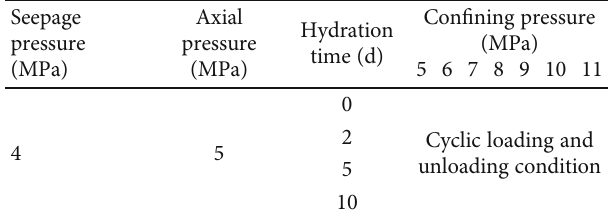
Figure 2: The shale samples with di ff erent hydrating days. The labels in Fig.2 are as follows, (a)No hydration (b) 2days (c)5 days (d) 10days. Table 1: The seepage tests of the hydrated shale under cyclic loading and unloading